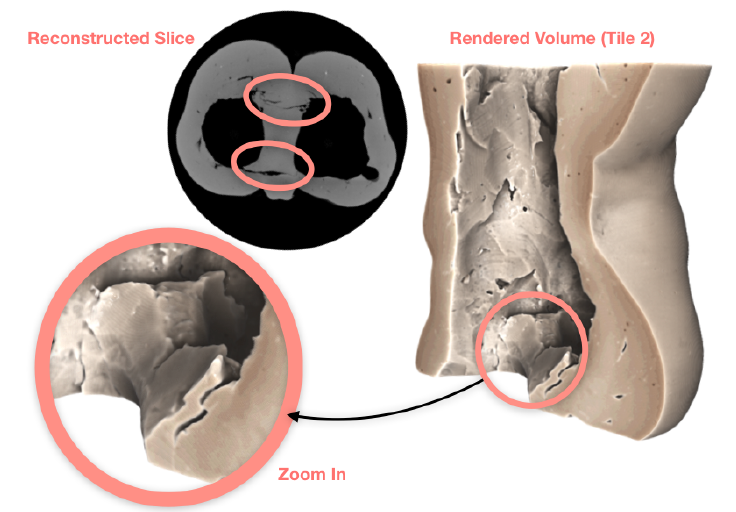
Figure 8. The joint lines with gaps at their largest. Gaps are circled both on the reconstructed cross-sectional slice and the volume rendering, including a zoom-in on the top of additional